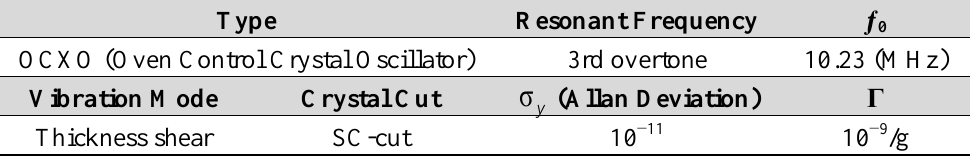
Table 1. Characteristics of the GPS disciplined crystal oscillator.